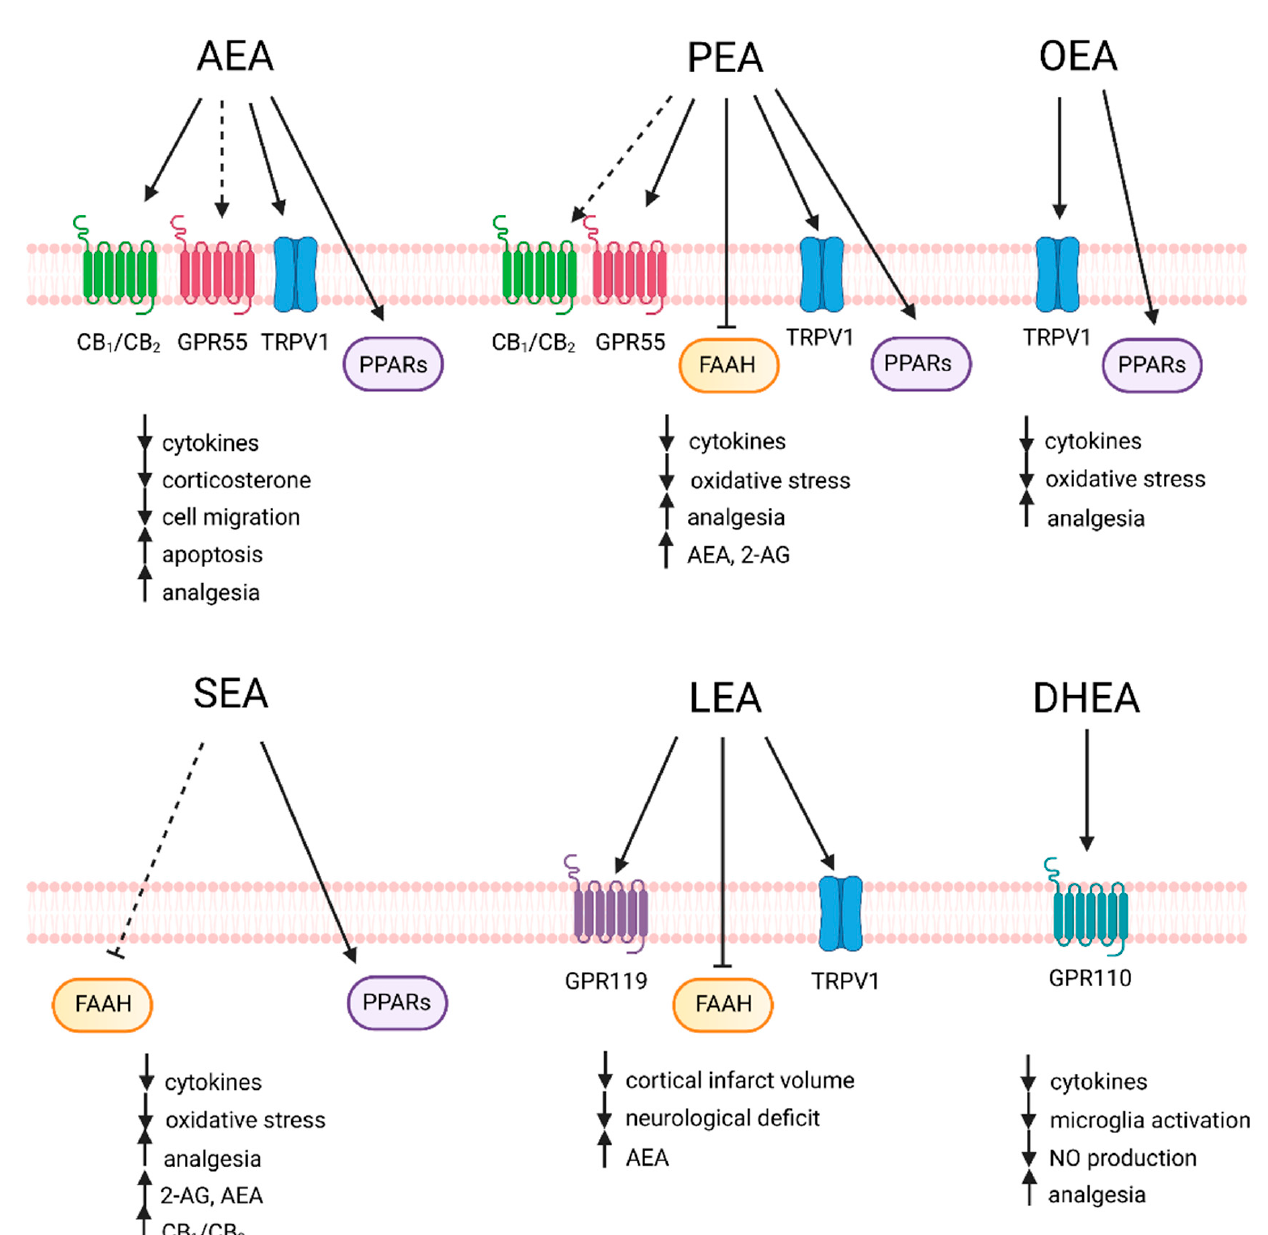
Figure 3. Signaling pathway and anti-inflammatory actions of NAEs. Arachidonoylethanolamide (AEA) signals via the cannabinoid receptors CB 1/2 , the non-cannabinoid G protein coupled receptor (GPR)55, the transient receptor potential cation channel subfamily V member 1 (TRPV1), and the peroxisome proliferator-activated receptor (PPAR)- α and γ . Palmitoylethanolamide (PEA) has been shown to inhibit the fatty acid amide hydrolase (FAAH) and to signal via GPR55, TRPV1, and PPAR- α , while CB 1/2 binding is still controversial. Oleoylethanolamide (OEA) activates TRPV1 and PPAR- α , while stearoylethanolamide (SEA) inhibits FAAH and activates PPAR- α . Linoleylethanolamide (LEA) was shown to activate TRPV1, GPR119, and to inhibit FAAH, while docosahexaenoylethanolamide (DHEA) signaling involves the activation of GPR110.